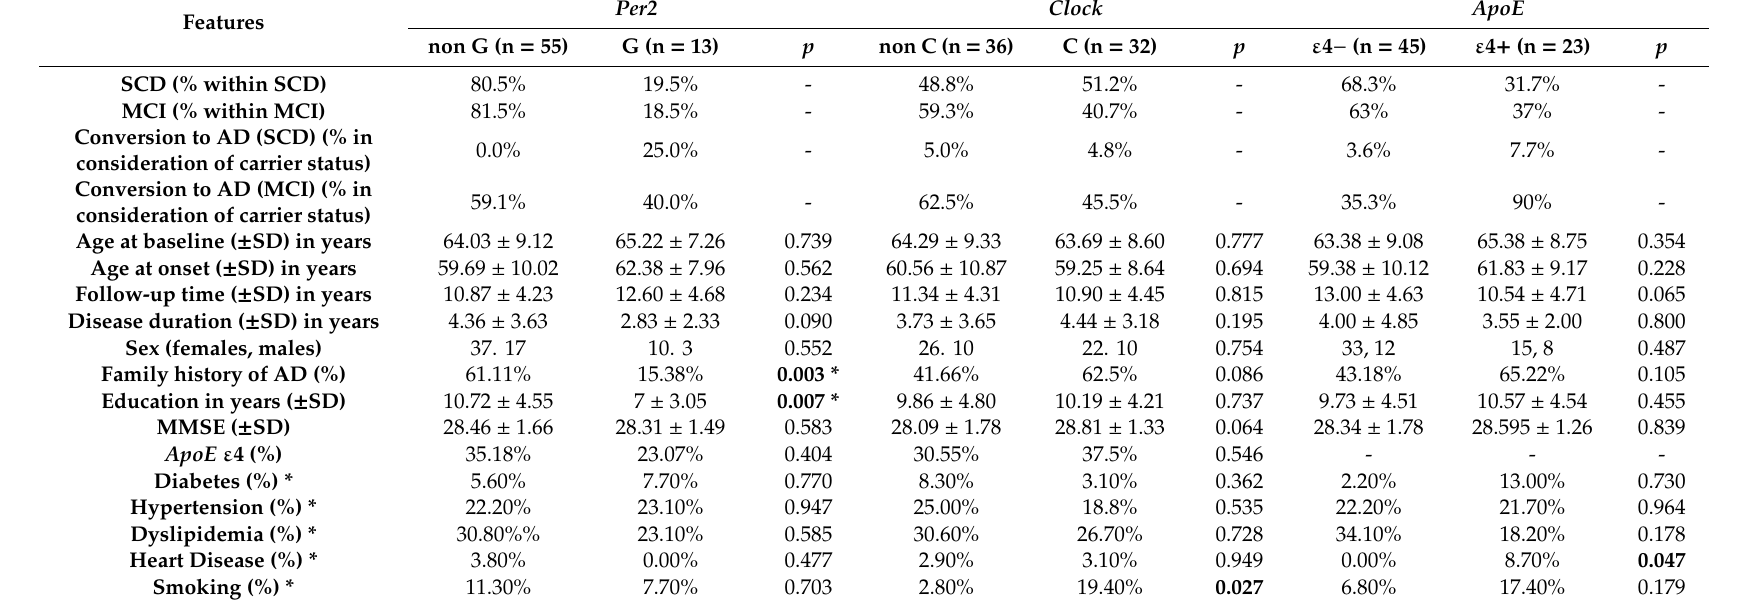
Table 2. Demographic data according to Per2 , Clock , ApoE